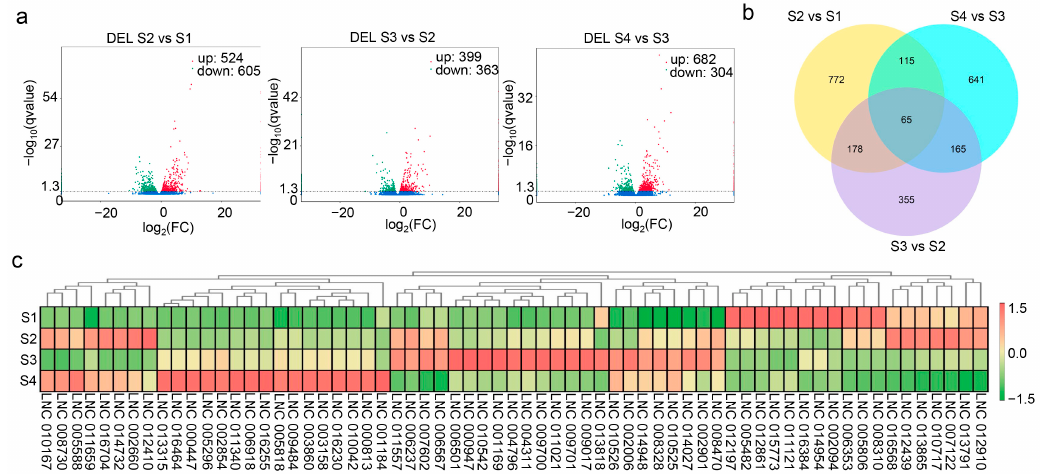
Figure 3. Differentially expressed lncRNAs and their expression profiles. ( a ) Identified differentially expressed lncRNAs (DELs) in S2 vs. S1, S3 vs. S2, and S4 vs. S3. ( b ) Venn diagram of DELs in all three comparisons. ( c ) Heatmap of the expression levels of 65 DELs that existed in all three comparisons.